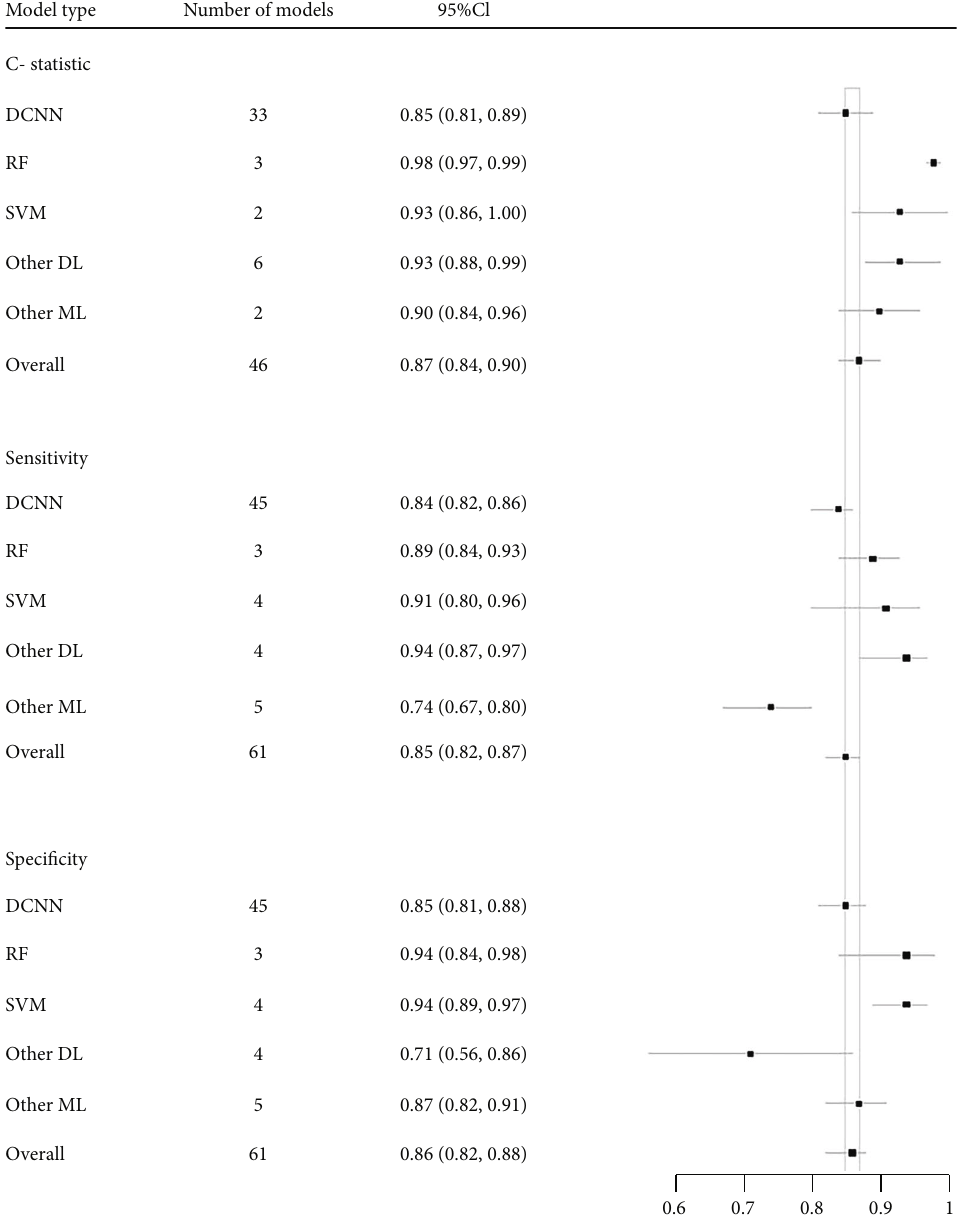
Figure 2: Forest maps of C-statistic, sensitivity, and speci fi city of di ff erent machine learning